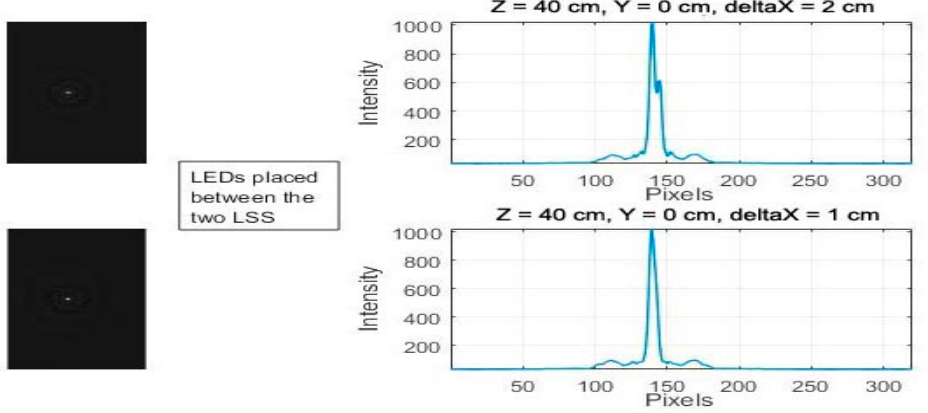
Figure 2. Light-emitting diodes (LEDs) placed at Z = 40 cm moved closer from 2 cm and 1 cm. (ii) Occlusion—Occlusions occur when the light source is moved away from the sensor focal point along the X -axis. In Figure 3, at extreme lateral positions when the FoV ≥ 40 ◦ , even when the LEDs are 3 cm away, one LED is occluded by the other.